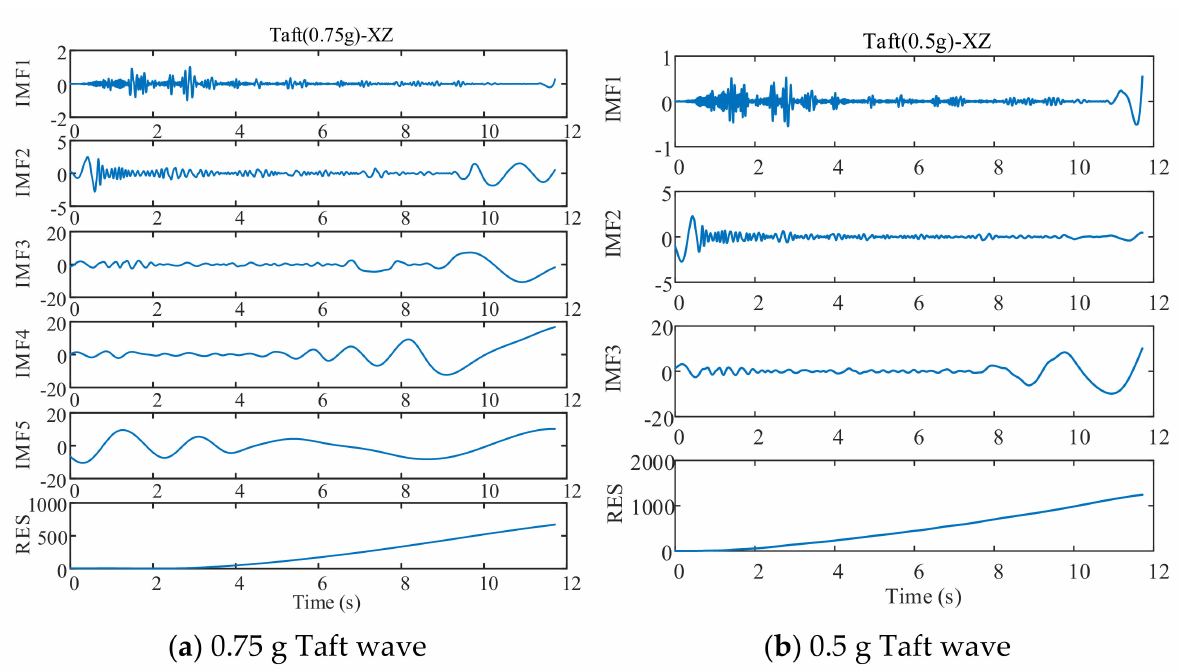
Figure 8. EMD decomposition of EL centro wave.